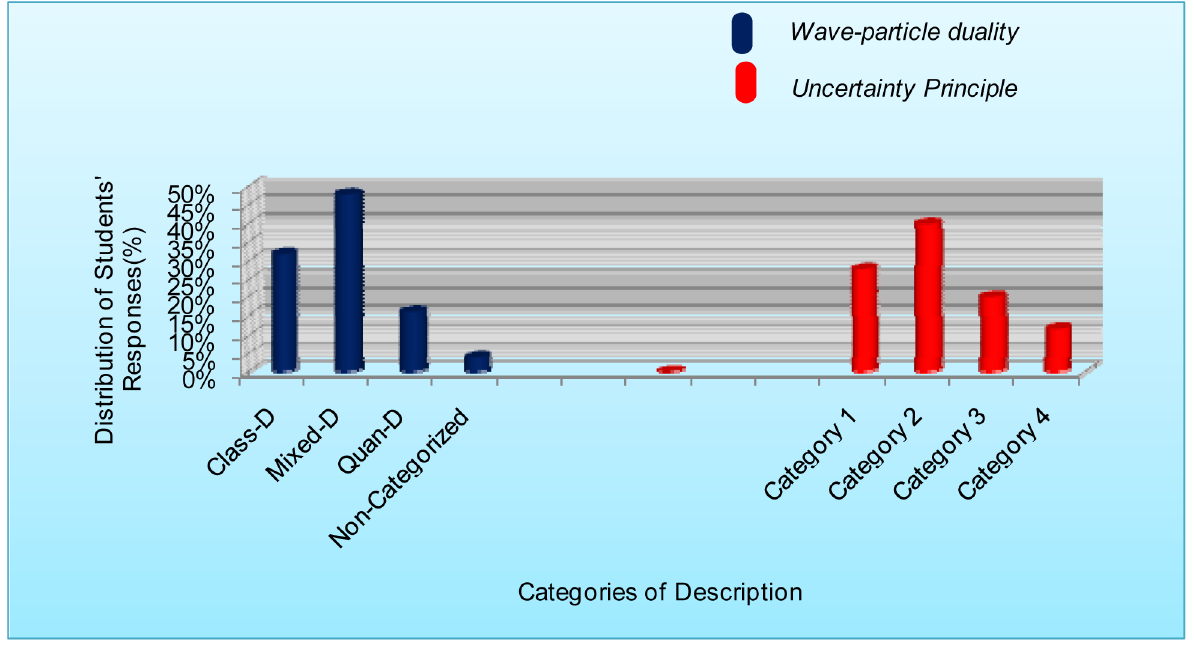
FIG. 2 (color online). Distribution of students’ responses in each category for the concepts wave-particle duality and the uncertainty principle. Codes: classical description (Class-D), mixed description (Mixed-D), and quasiquantum description